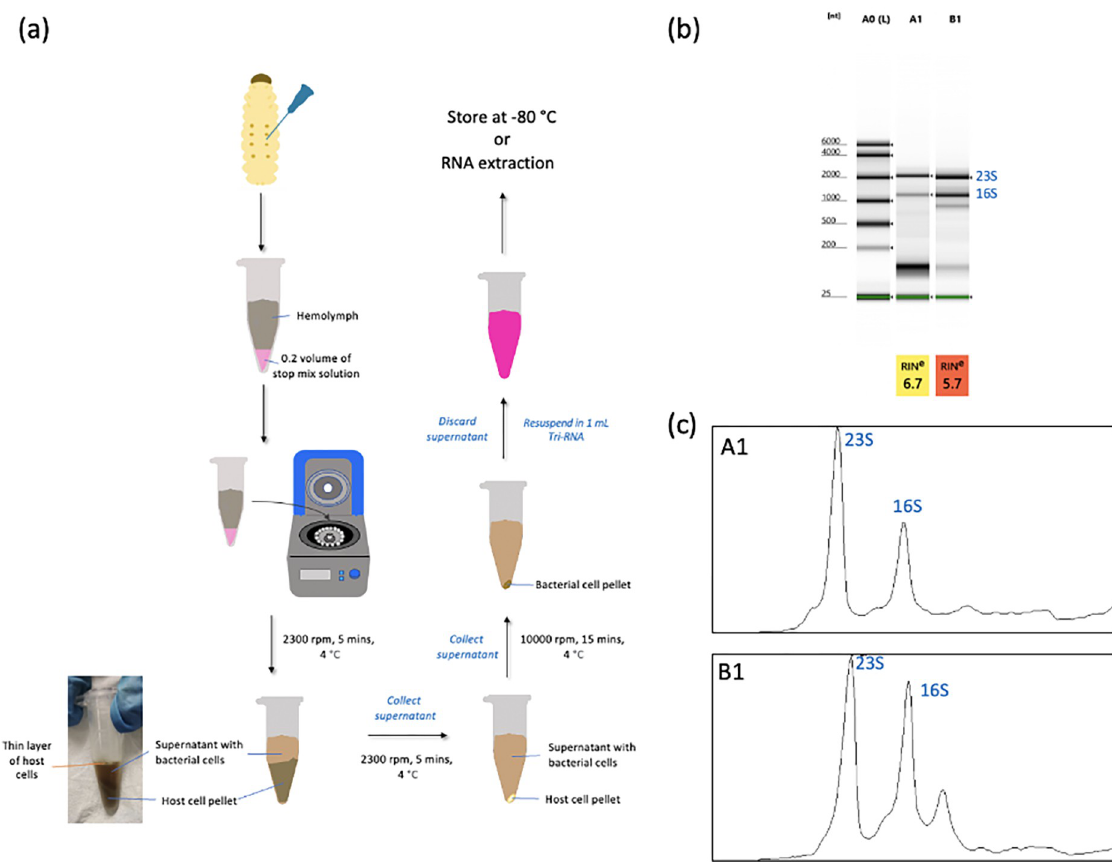
Fig 4. Bacterial RNA isolation from G . mellonella larvae infected by A . baumannii strain C98. (a) Steps of bacterial cell harvesting from the infected larvae. The host cells were removed by multiple centrifugations to minimize the contaminations of the host’s RNA. (b) Quality assessment of RNA samples using Agilent 2200 TapeStation System and the RIN numbers were calculated by TapeStation Software A.02.02. A0: Electronic ladder; A1: bacterial RNA from the mid-exponential phase in broth culture (control); B1: bacterial RNA from infected larvae after 3-hour infection. (c) ImageJ quantification of bacterial RNA from the infected larvae (B1). Ratios of 23S:16S were calculated by the Area Under the Curve to assess the RNA integrity.